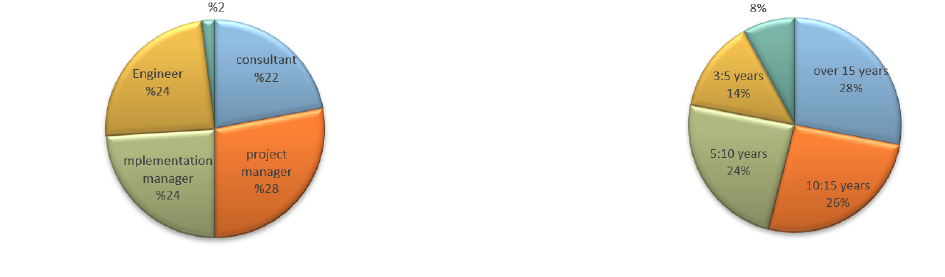
Fig. 4: Rate of respondents based on years of experience and occupation. Fig. 4 Alt Text: Rate of respondents based on years of experience and occupation. It shows that many respondents (28%) have more than 15 years of work experience in the construction industry, (28%) working as project